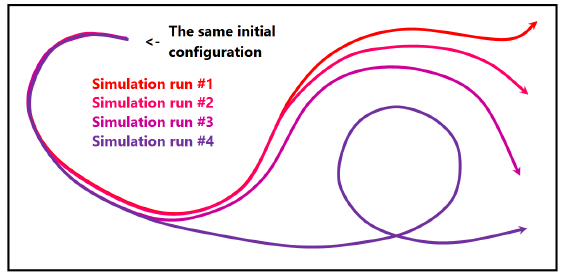
Figure 2. Schematic illustration of the similarity plot idea. Curves represent simulation states over time, where distances between points on the curves represent dissimilarity of corresponding simulation